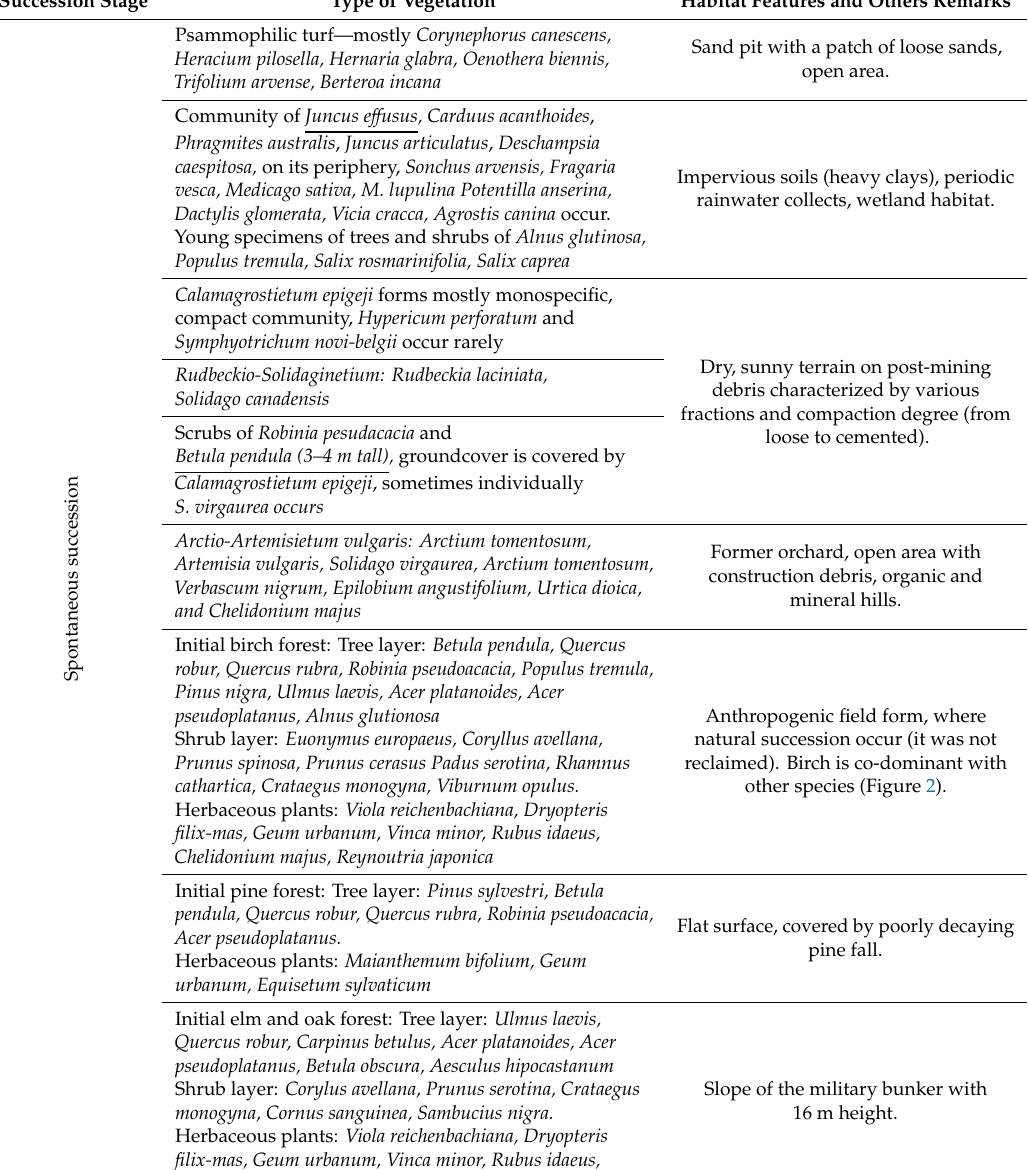
Table 1. The main types of vegetation during the